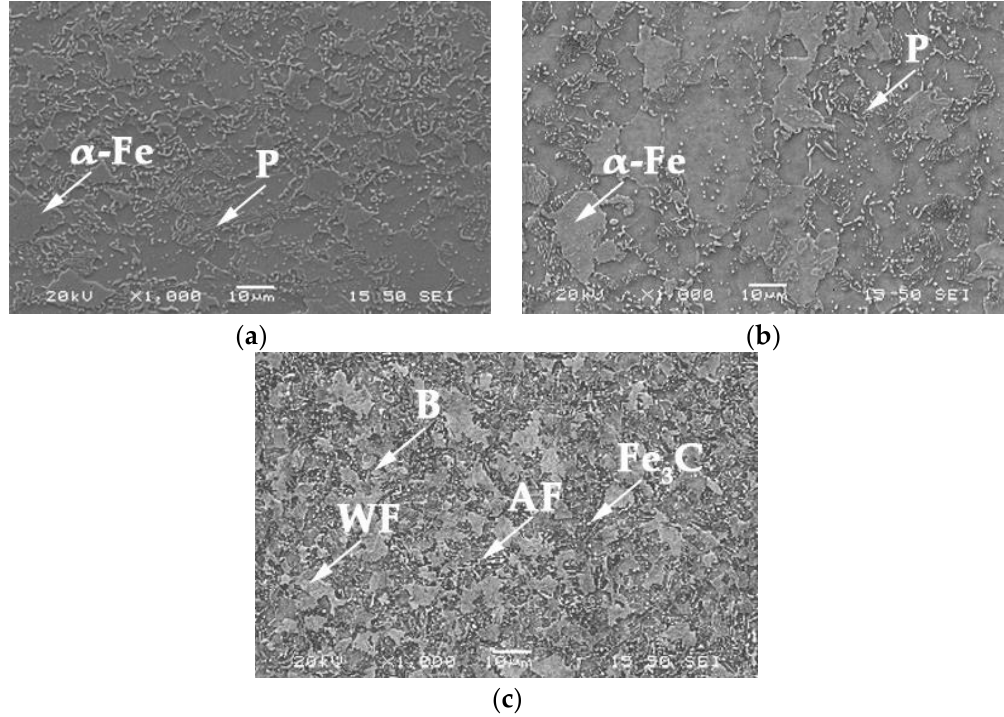
Figure 6. SEM metallographic images from ( a ) base metal; ( b ) heat affected zone and ( c ) fusion zone of the AISI 1008 welded sample. (Marked phases: P: pearlite, AF: acicular ferrite, WF: Widmanstätten ferrite, B: bainite, Fe 3 C: cementite).